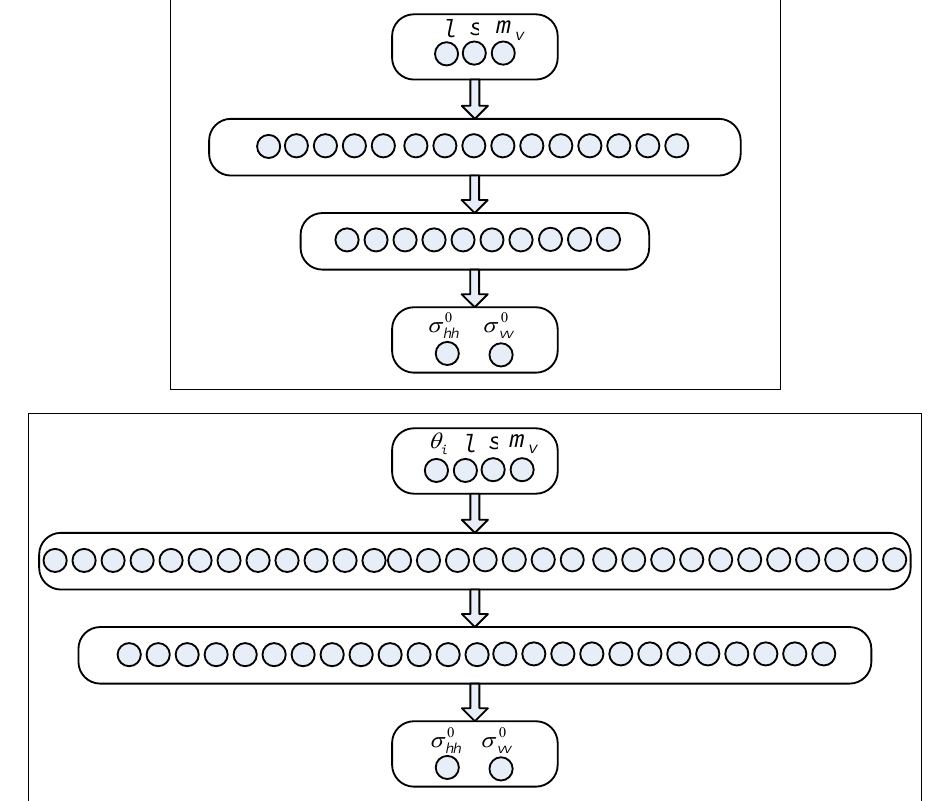
= 3, N = 15, N = 10, N = 2); lower panel: NN topology for i h 1 h 2 o